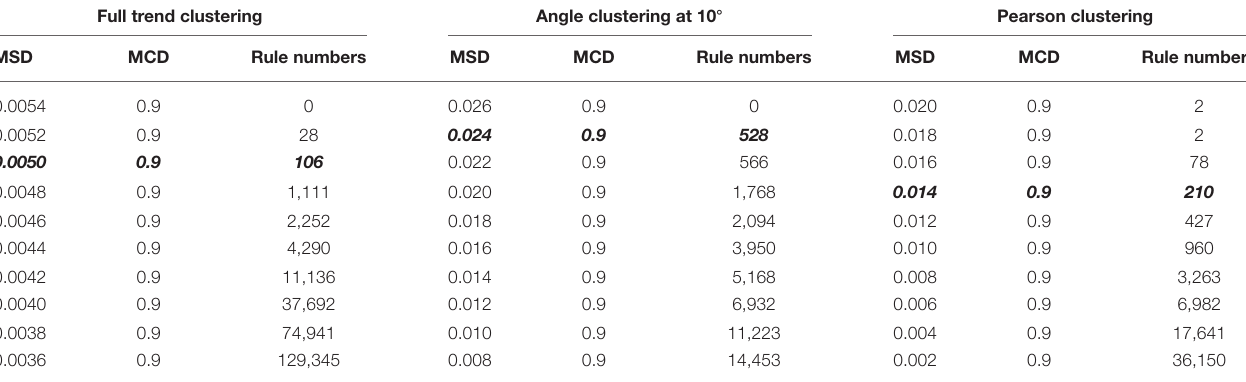
TABLE 1 | The numbers of interclass inference rules using different minimum supporting degrees and confidence degrees. Full trend clustering Angle clustering at 10 ◦ Pearson clustering Rule numbers MSD MCD Rule